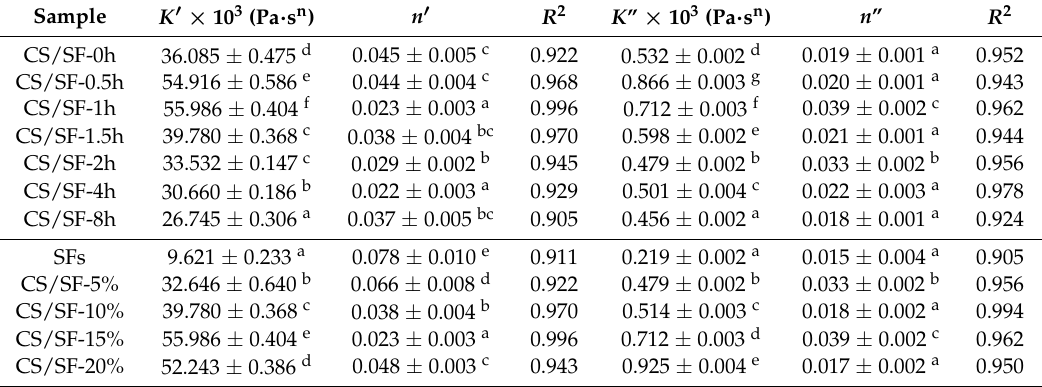
Table 4. The parameters of power law models for CS/SFs with different ball milling times and addition amounts.